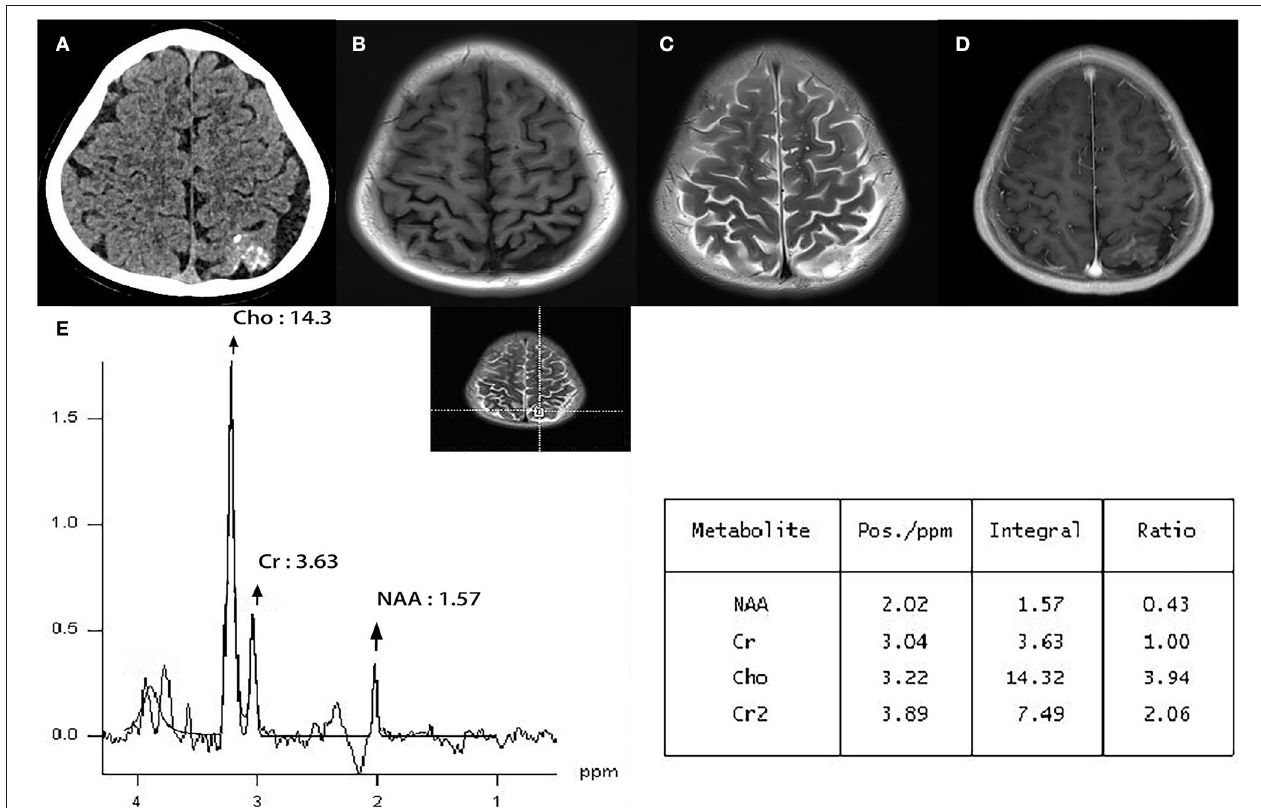
FIGURE 1 | Plain CT demonstrated a hyperdense lesion with multiple calcifications and proliferating adjacent blood vessels in the left parietal lobe. (A) T1-weighted MRI showed hypointense irregular abnormal cortical and subcortical regions. (B) T2-weighted MRI demonstrated a hyperintense mass. (C) MR post gadolinium enhancement showed enhanced pia mater and cortex. (D) Magnetic resonance spectroscopy (MRS) revealed decreased NAA and increased Cho in the lesion. The Cho/Cr ratio was markedly elevated (3.94), while the NAA/Cr ratio was reduced (0.43) in the lesion area (E)